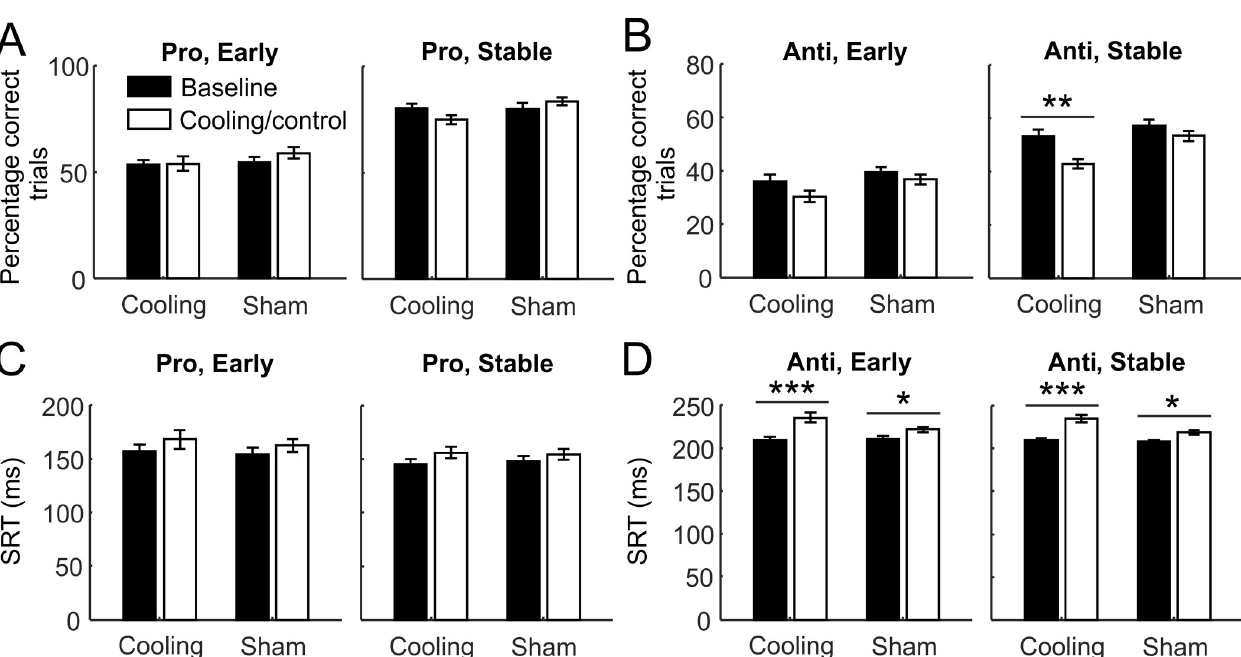
Fig 4. The impact of dACC deactivation on behavioral performance depended on the post-switch stage and the rule. Behavioral performance at 2 different post-switch stages. The Early stage included the first to the fourth trial post switch, and the Stable stage included the fifth to the 12th trial. See S3 and S4 Tables for complete sets of result from statistical tests. (A) Performance as measured by the percentage of correct trials did not change from the baseline to the cooling or control epoch in either the Early (left panel) or the Stable stage (right panel). (B) Cooling (left bars) but not epoch per se (right bars) significantly impaired the animals’ performance at the Stable stage (right panel) but not the Early stage (left panel). (C) Cooling did not affect the SRTs of correct responses in prosaccade trials in either stage alone, but when considered together, it increased the SRTs more strongly in cooling than in control epoch compared with the baseline epochs. (D) There was a cooling × epoch interaction: while the SRTs in both the Early (left panel) and the Stable stages (right panel) increased from the baseline to the control epochs (right bars), they increased more strongly from the baseline to the cooling epochs (left bars). The error bars indicate standard error of the mean. Asterisks indicate significant difference by post hoc Tukey’s test between adjacent bars below the horizontal lines. Data associated with this figure can be found at 10.6084/m9.figshare.8236589. � p < 0.05 �� p < 0.001 ��� p < 0.0005. dACC, dorsal anterior cingulate cortex; SRT, saccadic reaction